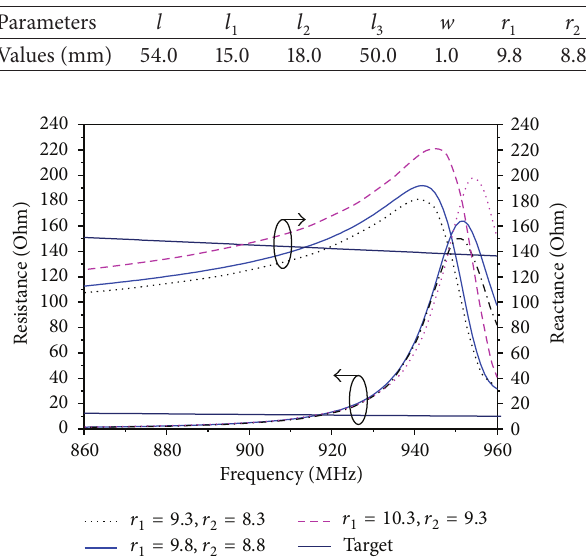
Figure 6: Simulated impedance of the proposed antenna with different sizes of the feed loop.